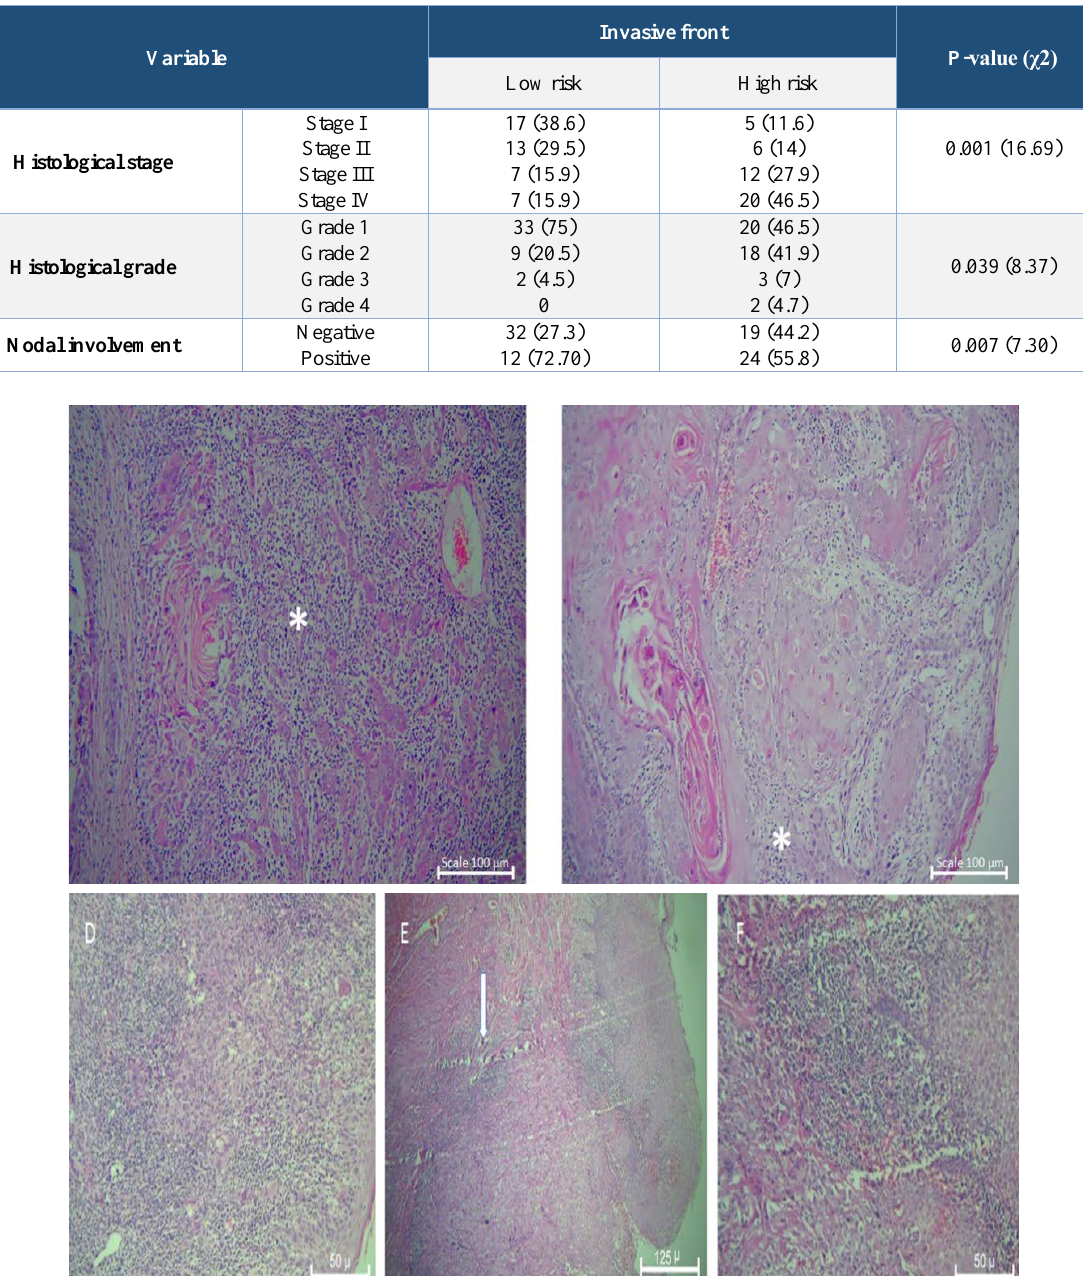
Table 2. Relation of invasive fronts with studied clinicopathological parameters